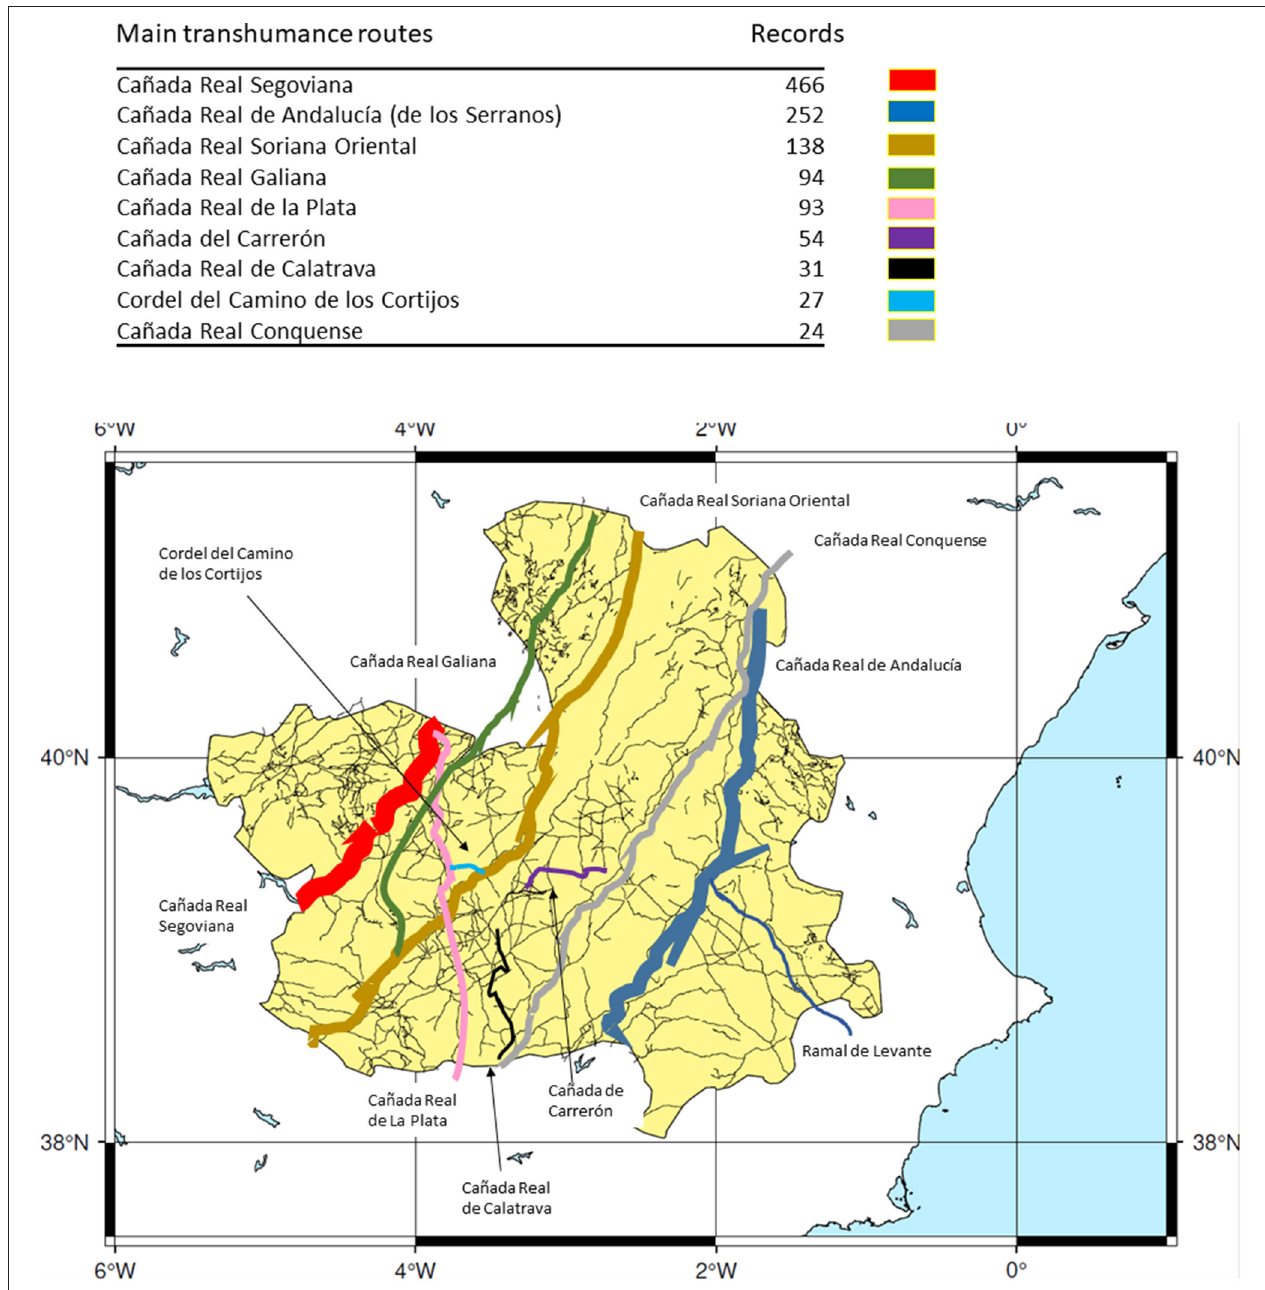
FIGURE 1 | Location map of the studied transhumance routes in Castilla-La Mancha. Note: the width of each one of the routes is proportional to the number of records linked to this particular route. Map: F. Alcaraz.